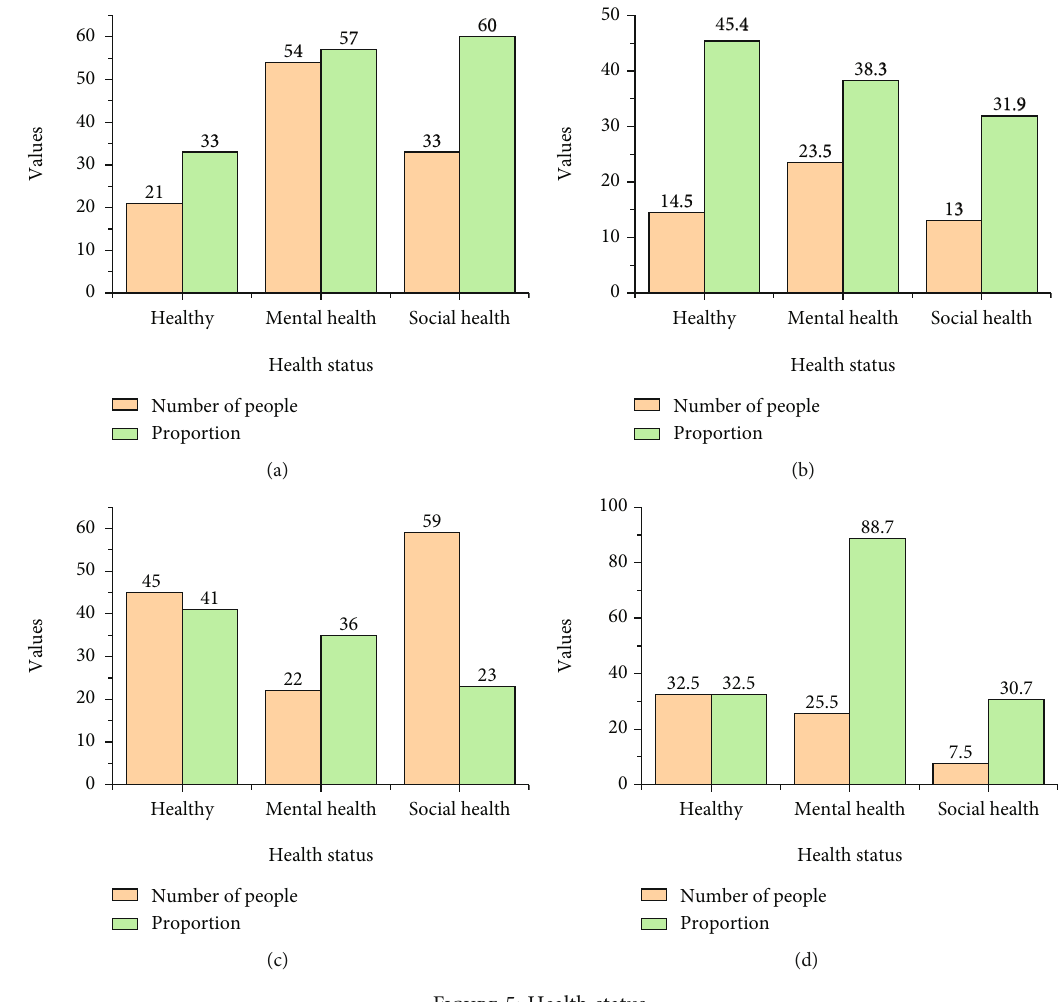
Figure 5: Health